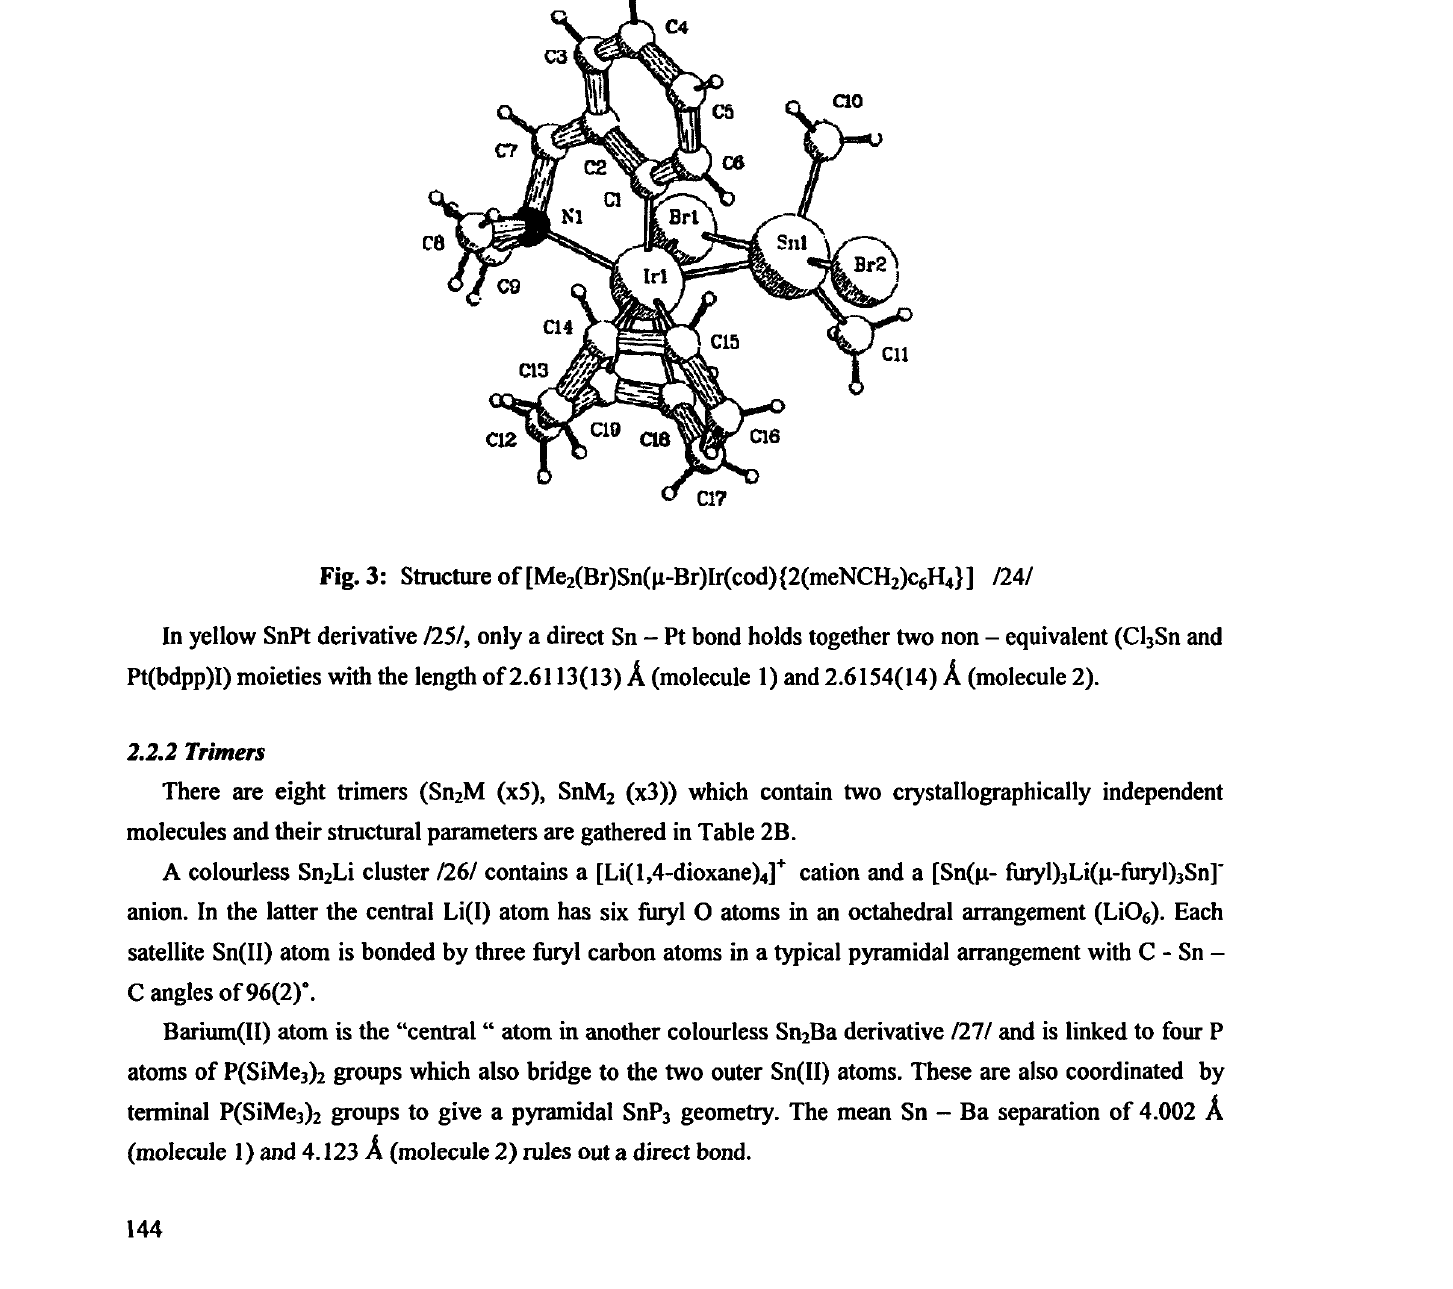
Fig. 3: Structure of [Me